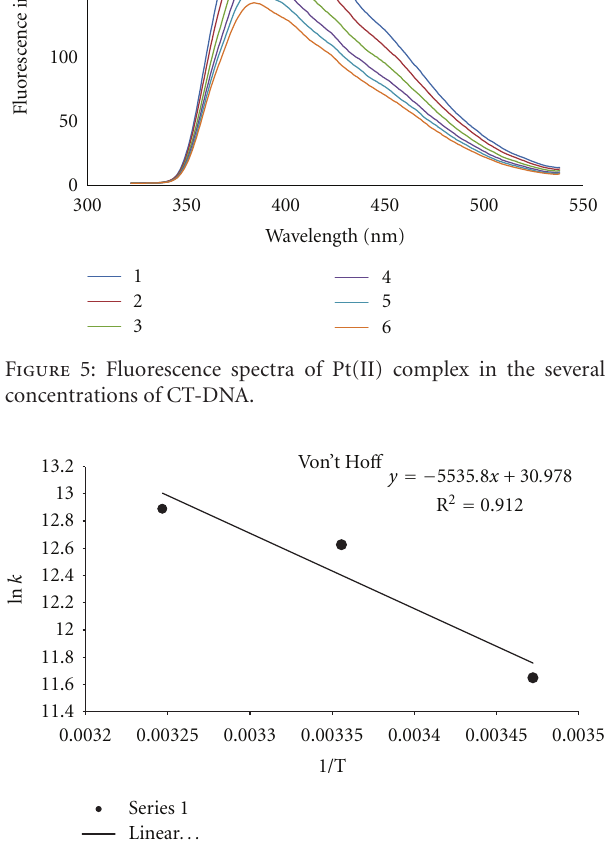
Figure 6: Van’t Ho ff plot for the interaction of the Pt(II) complex and CT-DNA at pH 7.2.